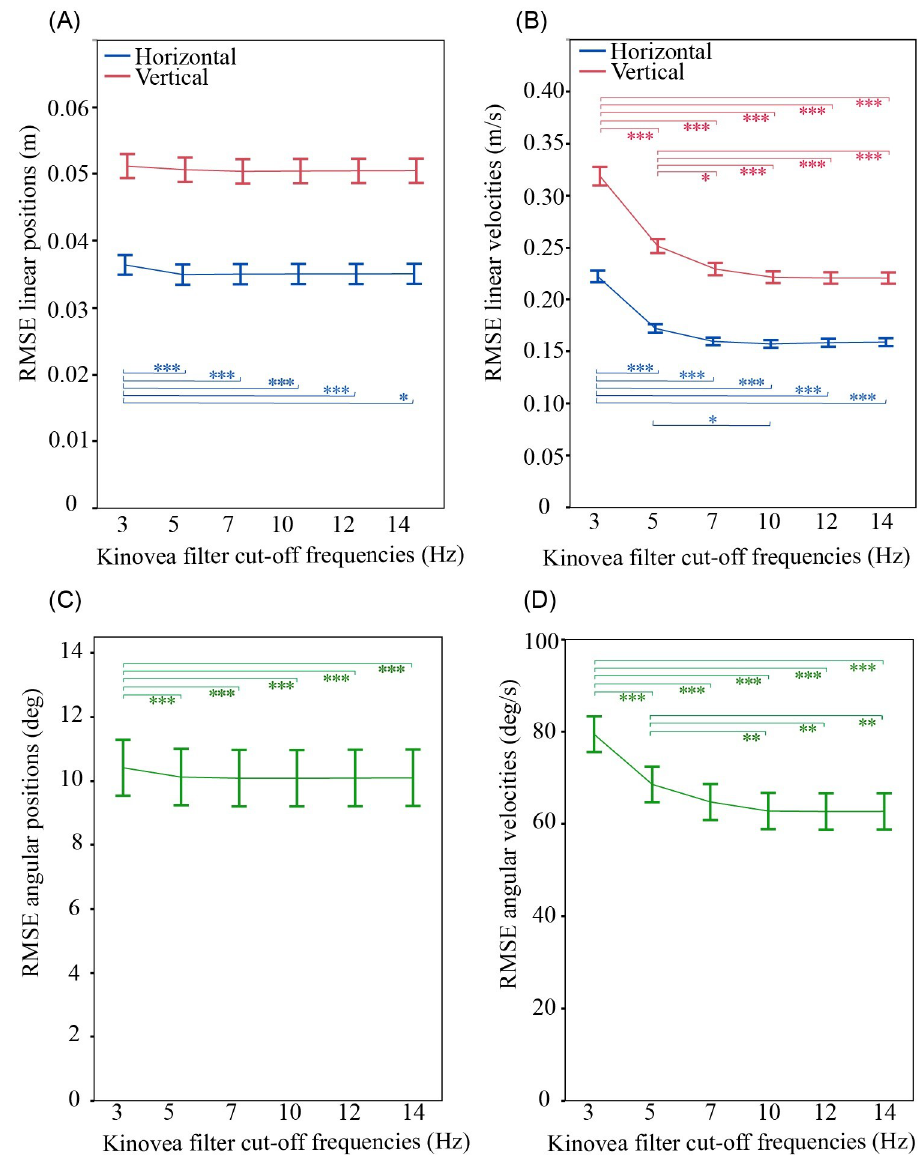
Fig 4. Effect of low-pass filter cut-off frequency on the accuracy of Kinovea estimates. (A) Linear position, (B) linear velocity, (C) angular position, and (D) angular velocity. The plots show root mean square errors (RMSE) for Kinovea data filtered at cut-off frequencies of 3, 5, 7, 10, 12 and 14 Hz, based on comparison with Qualisys ground truth signals. Results are specific to Kinovea data from the 90 deg camera angle, calibrated with the calibration frame located in the plane of the fall. Data points show mean values averaged across all body parts and fall directions with error bars showing ± 1 SE. � p � 0.05, �� p � 0.01, ��� p � 0.001.